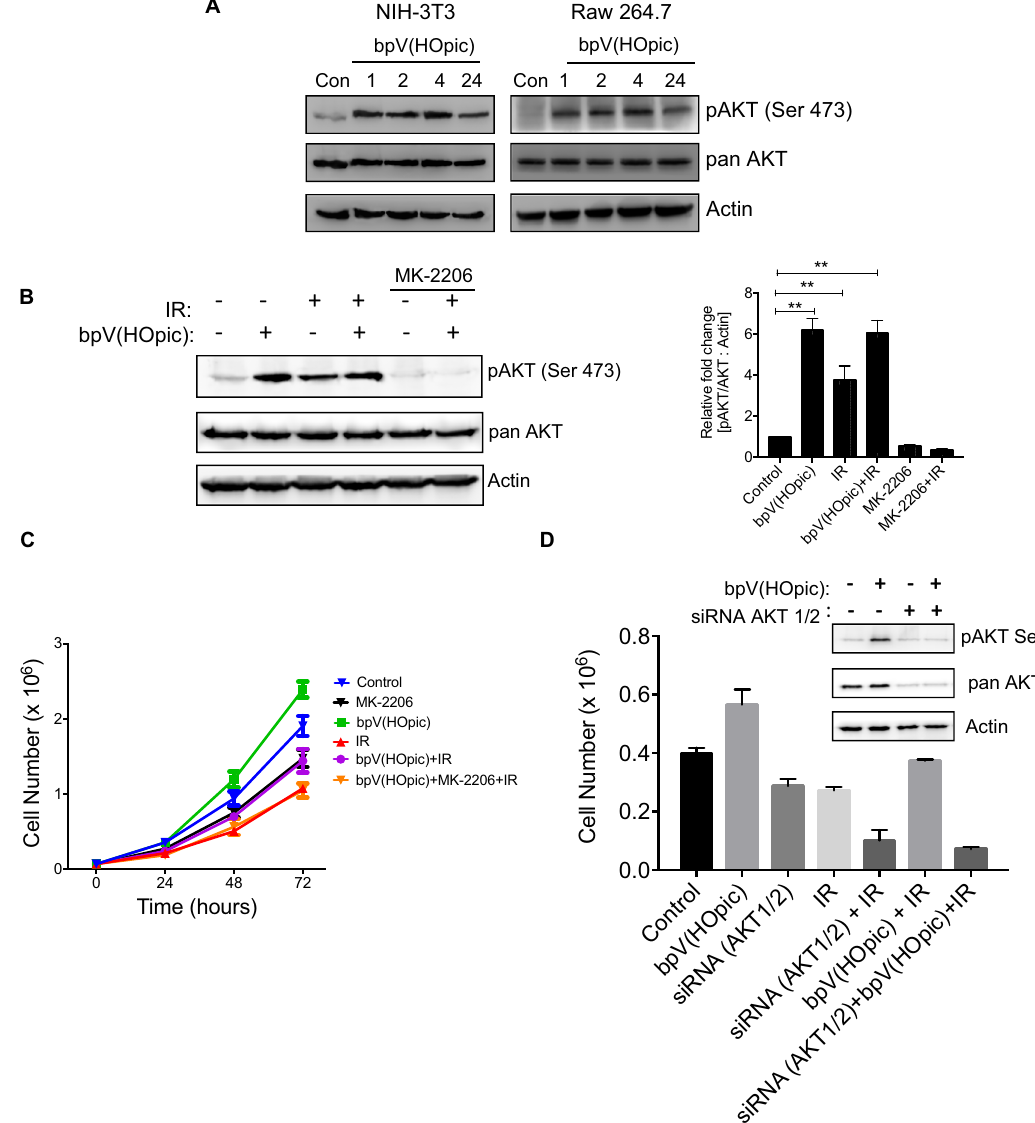
Figure 5. bpV(HOpic) confers radio-protection by activating AKT signaling. ( A ) NIH-3T3 and Raw 264.7 cells were treated with bpV(HOpic) for indicated timepoints and AKT activation was assessed from whole cell lysate immunoblotting for pAKT and AKT protein levels. ( B ) Effect of bpV(HOpic) pretreatment on the status of AKT signaling in irradiated NIH-3T3 cells. Cells were treated with 100 nmol/L bpV(HOpic) and/or 2.5 μM Akt inhibitor MK-2206 1 h before 4 Gy irradiation. At 1 h post-irradiation, cells were harvested, and whole-cell lysates were subjected to immunoblotting, and densitometry analysis for pAKT/AKT levels ( C ) Pharmacological inhibition of AKT signaling reverses bpV(HOpic) conferred radioresistance in NIH-3T3 cells. Cell pretreated with AKT inhibitor, MK-2206, were subjected to IR-exposure upon bpV(Hopic) treatment. Cell counts were taken at indicative timepoints for each group. ( D ) Genetic inhibition of AKT signaling reverses bpV(HOpic) conferred radioresistance in NIH-3T3 cells. Cells expressing scrambled or AKT siRNA were treated with 100 nmol/L bpV(HOpic) before 4 Gy IR exposure, and cell counts were done at indicated timepionts. Inset immunoblot represents the status of AKT signaling at the time of IR exposure. Error bars are mean ± SD (n = 4) from two independent experiments. * p < 0.05; ** p <